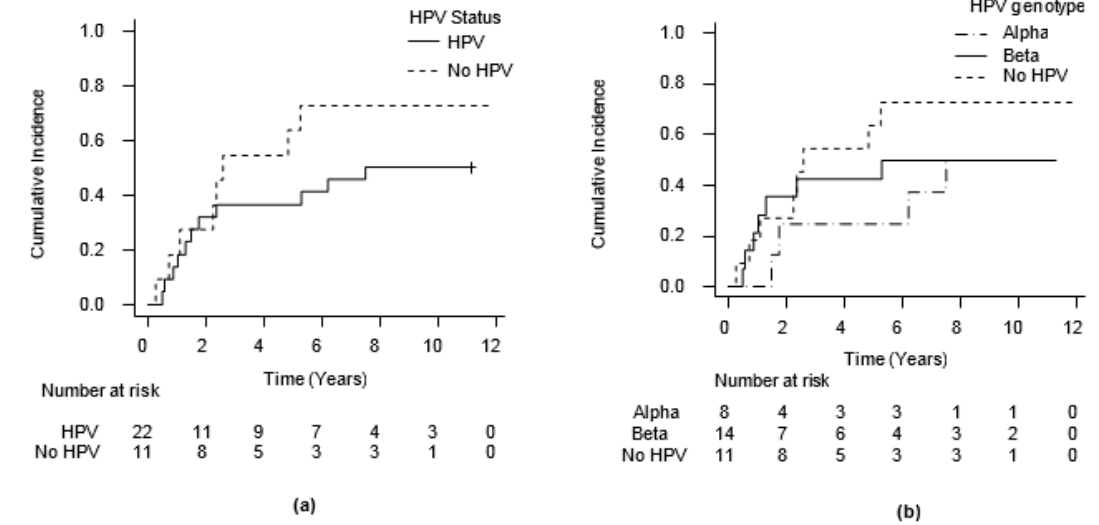
Figure 3. Cumulative incidence of recurrence. ( a ) Cumulative incidence of recurrence in relation to HPV presence, using competing risks (CR) method; ( b ) cumulative incidence of recurrence in relation to HPV genotype, using CR method. Sensitivity, specificity, PPV, and NPV of p16 in predicting HPV infection were